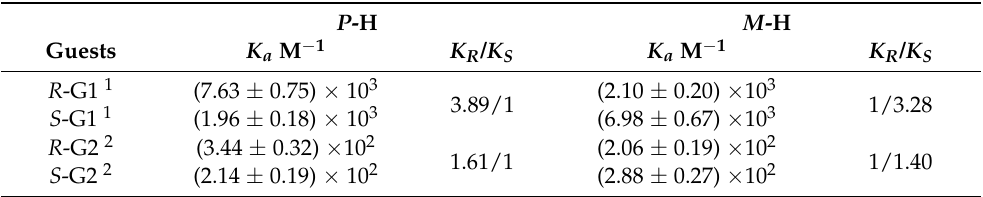
Table 1. Association Constants ( K a /M − 1 ) for 1:1 Complexes Between Chiral H and Chiral G1 – G2 at 298 K. P -H